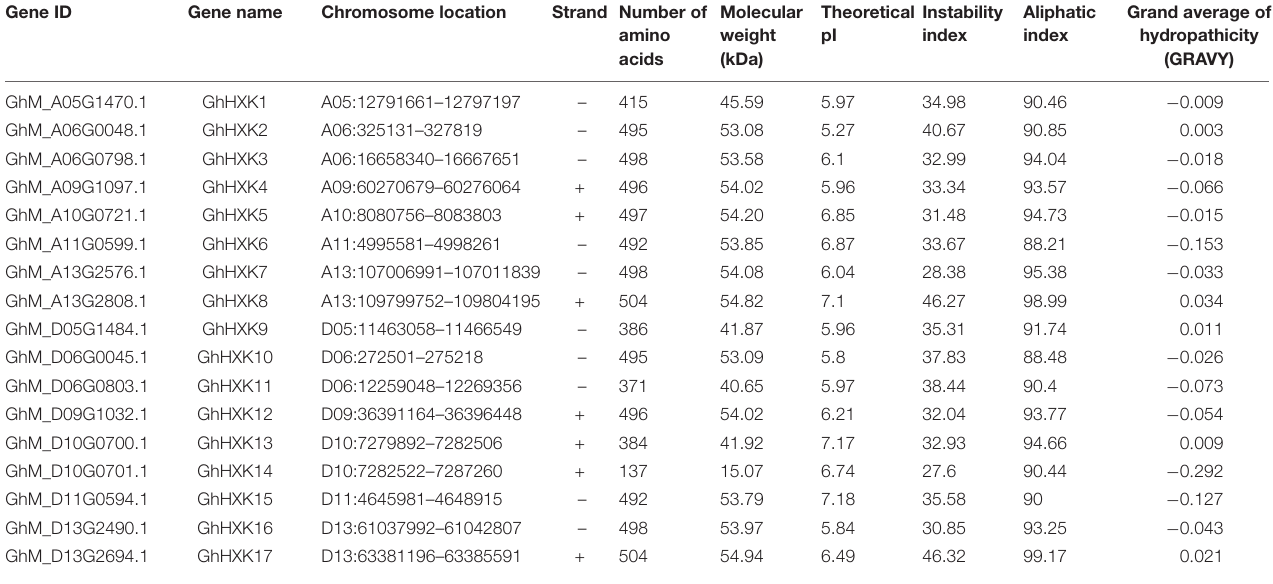
TABLE 1 | Detailed information about HXKs in G. hirsutum L.